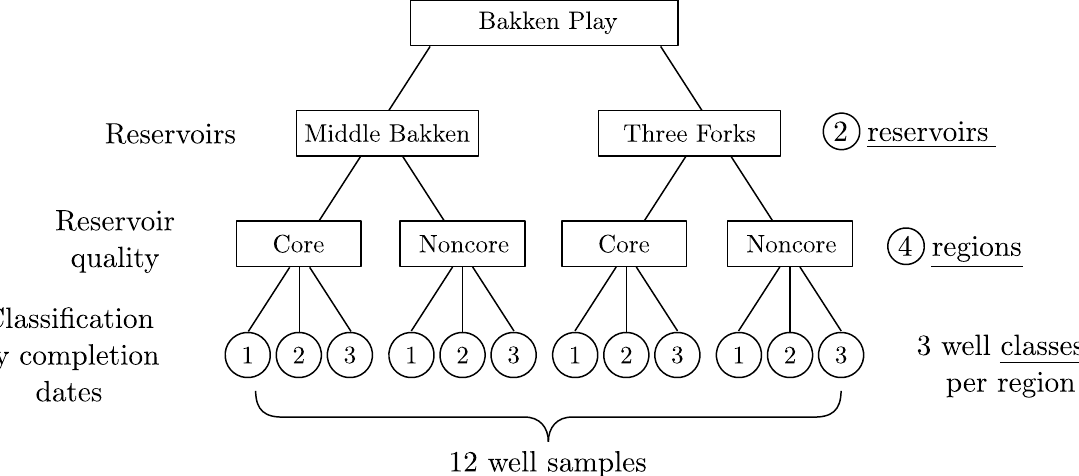
Figure 1. Division of the Bakken shale wells into 12 well